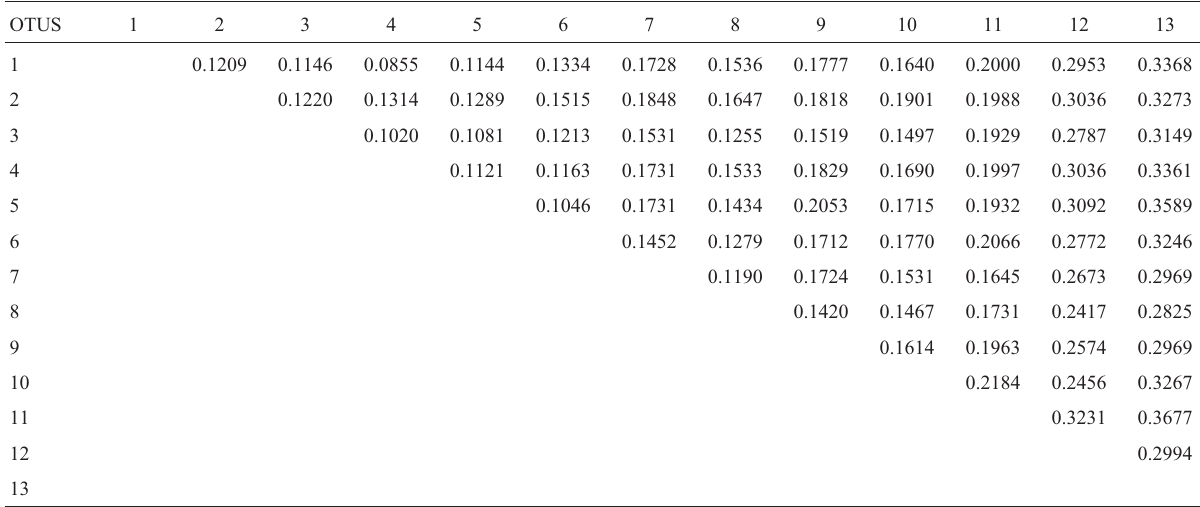
Table 3 - Matrix of interspecific distance (Gamma distance for the Kimura two-parameter model) in the mitochondrial COI fragment among twelve Chauliognathus species.